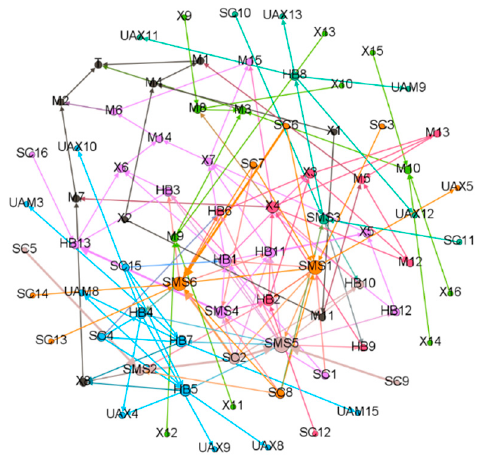
Figure 7. Association path diagram of accident causes.